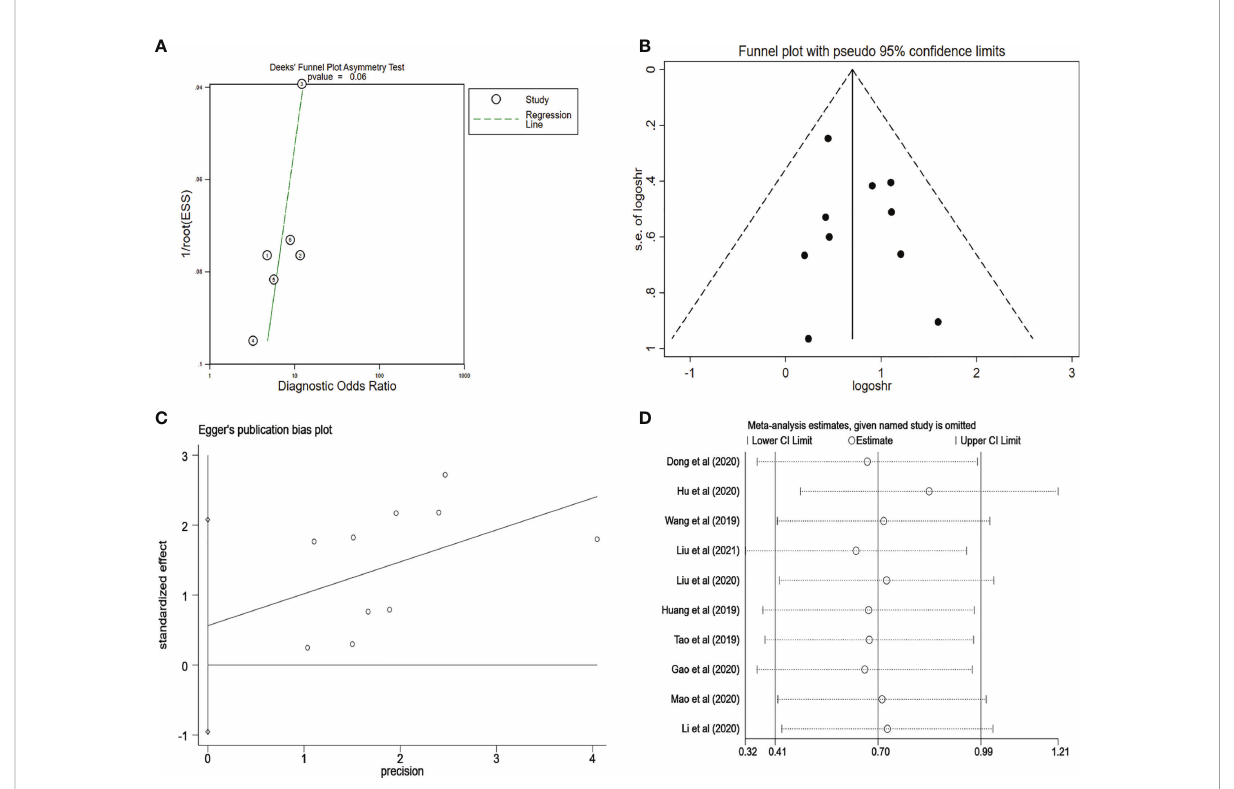
FIGURE 8 (A) Deeks ’ funnel plot for evaluating the publication bias of the included study on the diagnosis analysis. (B) Funnel plot for evaluating the publication bias of the included study on the prognosis analysis. (C) Egger ’ s funnel plot for evaluating the publication bias of the included study on the prognosis analysis. (D) Sensitivity analysis for evaluating the in fl uence of the omitted study on the pooled HR. PCa, prostate cancer; HR, hazard